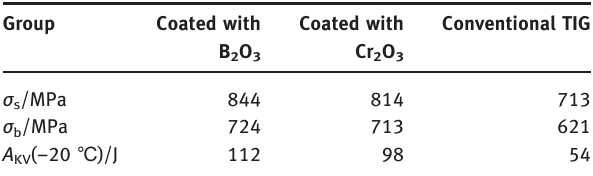
Table 4: Mechanical properties of BS700MC super steel. Group